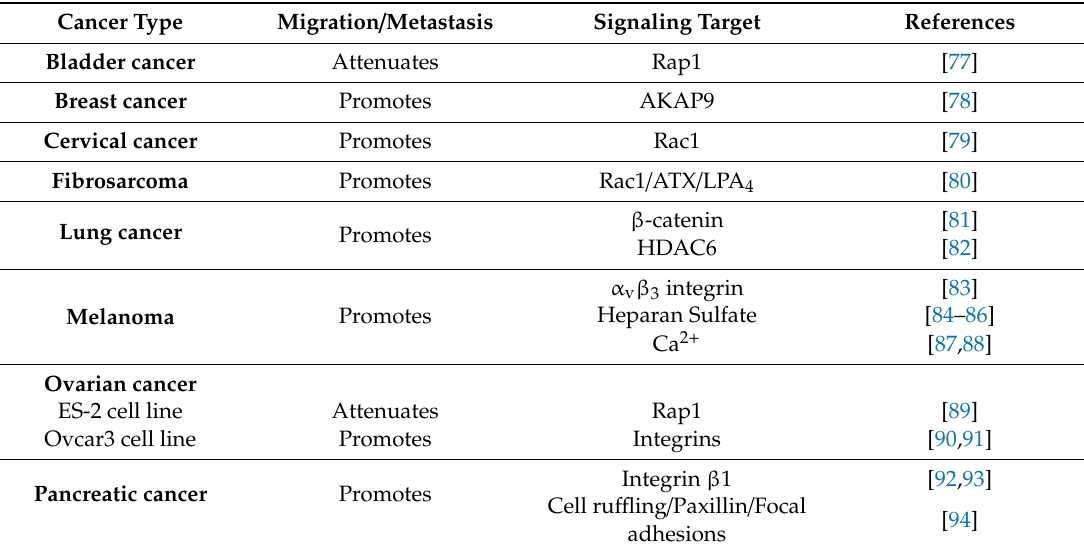
Table 2. Role of Epac in cancer cell migration / metastasis and its downstream signaling